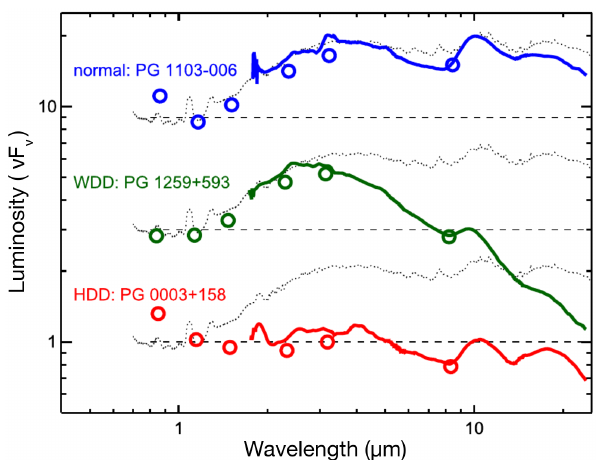
Figure 4. Near- to mid-IR spectra (solid lines) and photometry (open circles) for three representative Palomar–Green (PG) quasars to illustrate the variations in AGN intrinsic IR emission [41]. From top to bottom, PG 1103-006 is a “normal” AGN, PG 1259+593 is WDD, and PG 0003+158 is HDD. The dotted lines are the average, i.e., “normal” spectral templates for quasars compiled from the literature, as in Figure